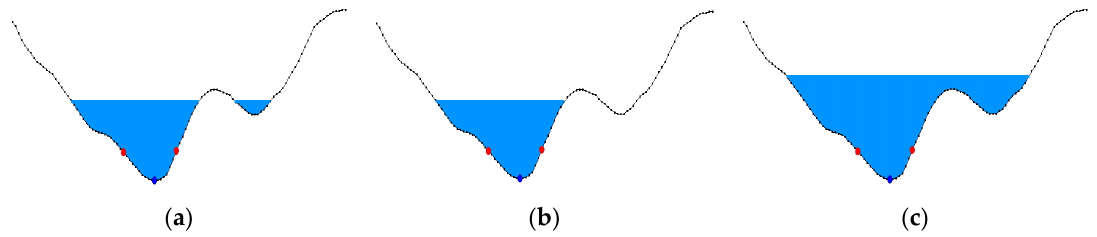
Figure 29. Explanation of a levee’s functionality: ( a ) without levee; ( b ) water level is lower than the levee’s elevation; and ( c ) water level is above the levee’s elevation.